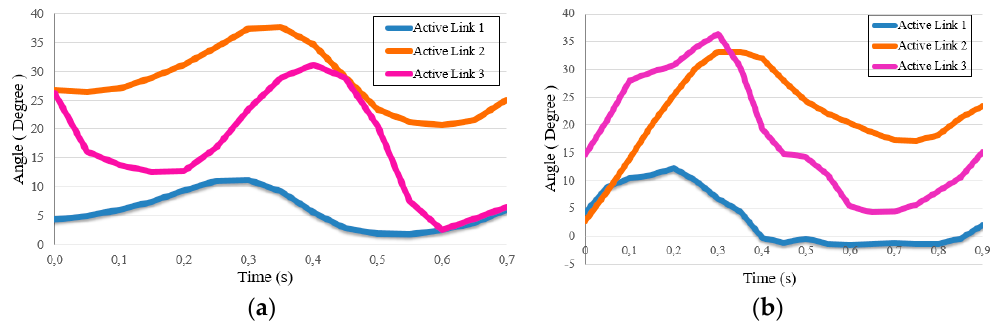
Figure 5. Real fish angles according to the active links: ( a ) Forward swimming mode; ( b ) Turning swimming mode.